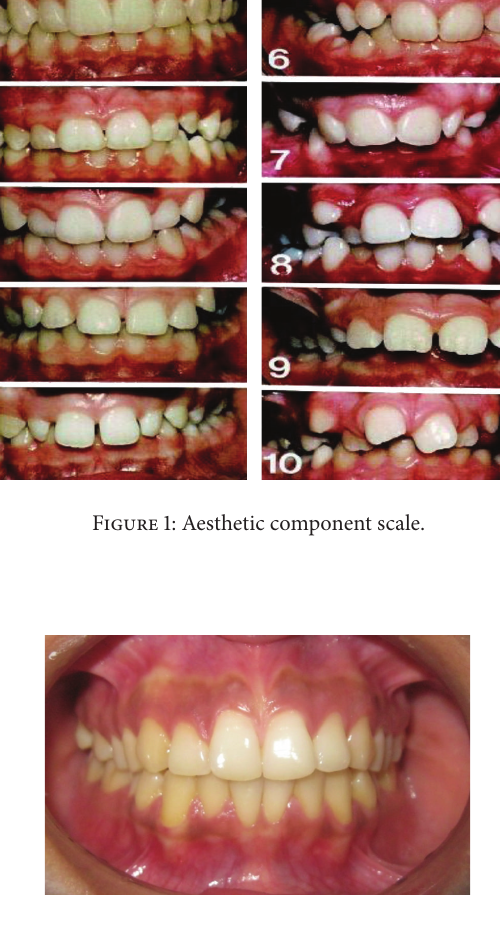
Figure 2: IOTN-AC Grade 1–4: no need for